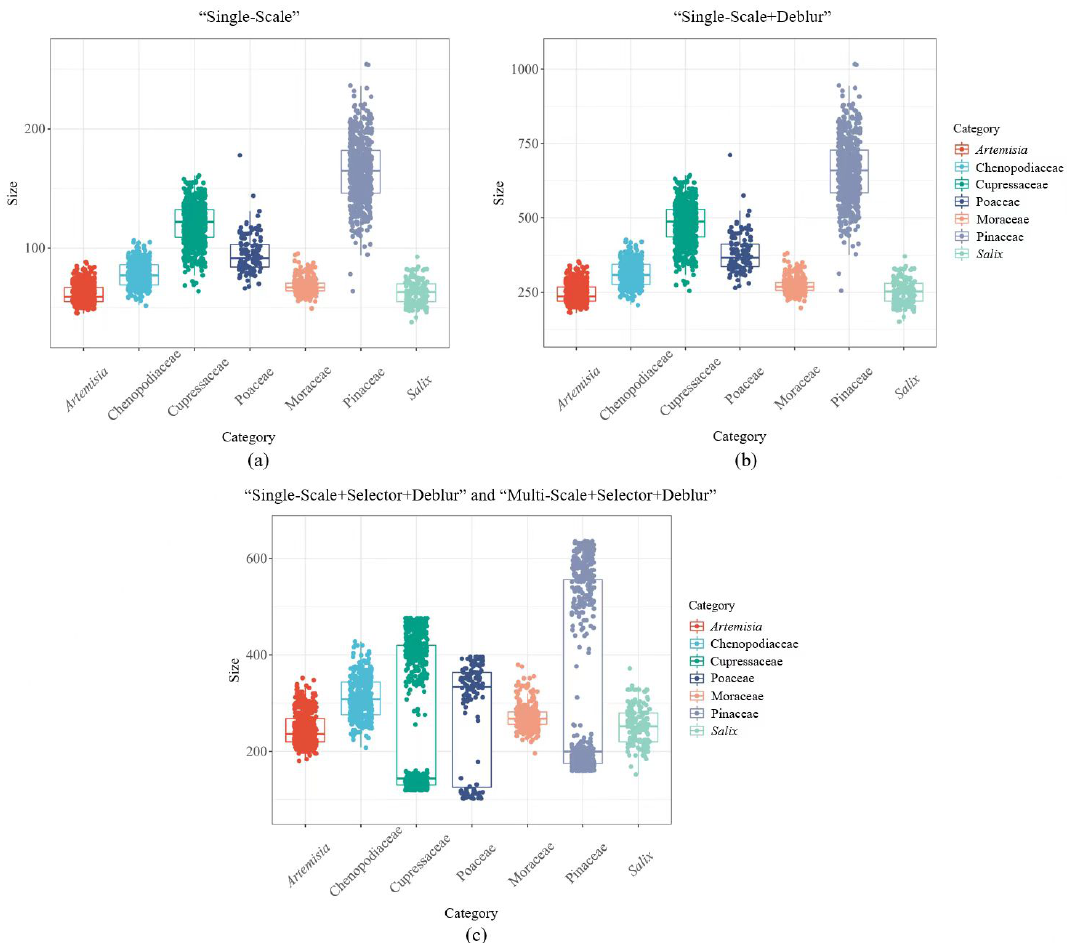
Figure 9. The boxplots of the image size/resolution of the samples in the seven categories of the ablation experiments: ( a ) “Single-Scale”; ( b ) “Single-Scale + Deblur”; ( c ) “Single-Scale + Selector + Deblur” and “Multi-Scale + Selector +